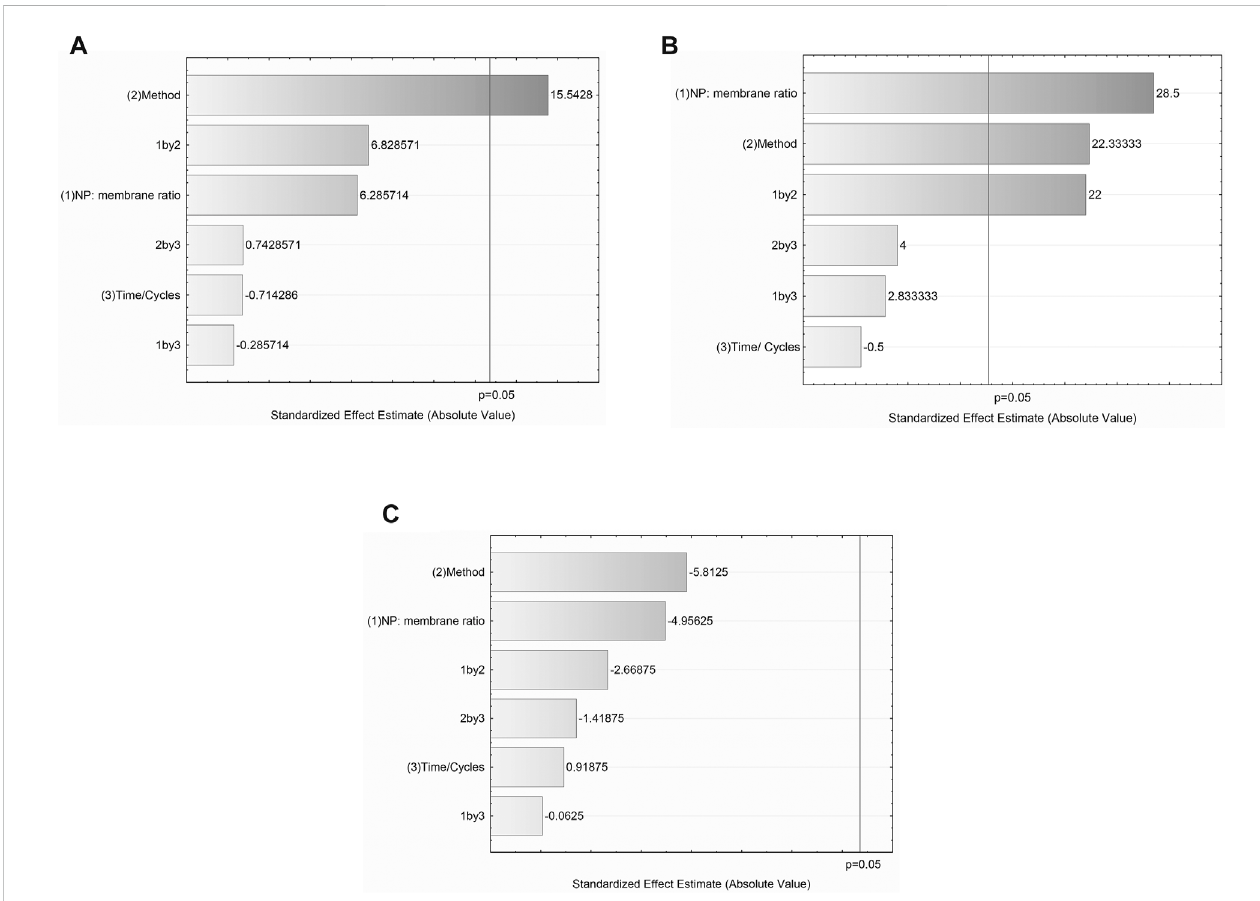
FIGURE 2 TheParetochartsofstandardizedeffectsrankedbytheirsigni fi canceforanyresponse. (A) Particlesize (B) PDI,and (C) ZP.Thedottedlinescorrespondto the p -value (0.05). Analyzed effects that are crossing this line are considered signi fi cant.